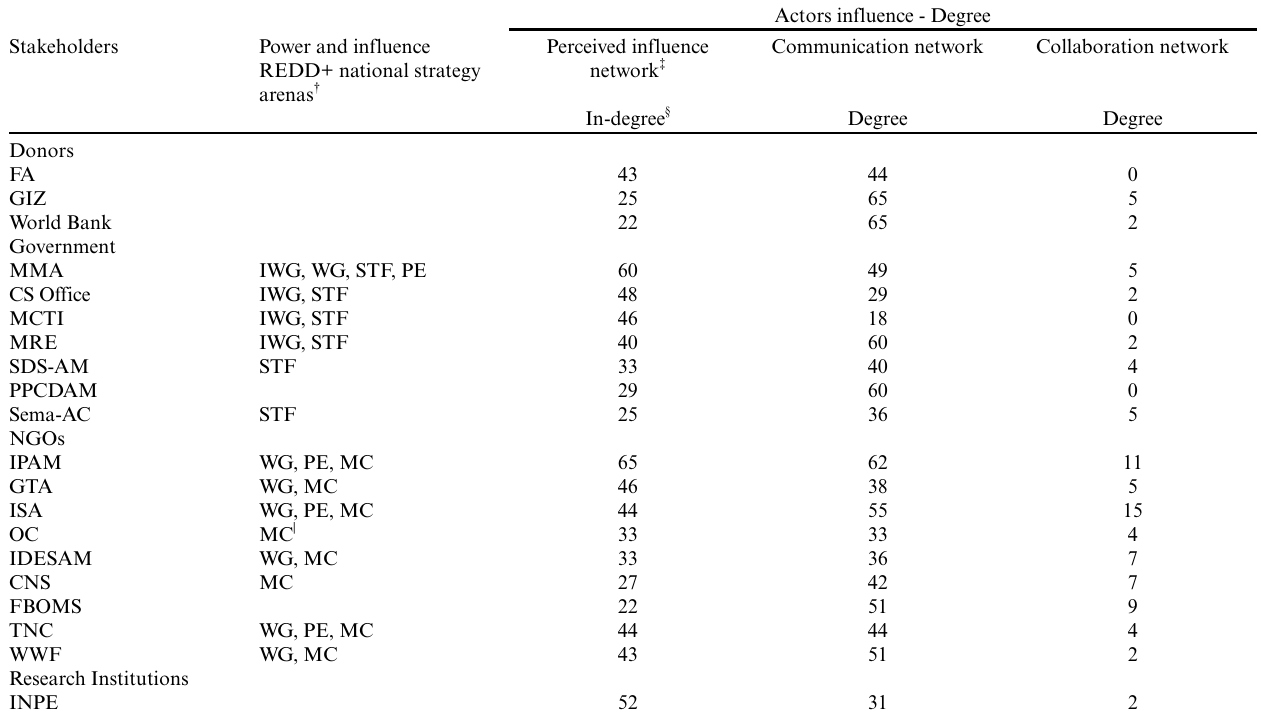
Table 1 . Centrality measures of policy